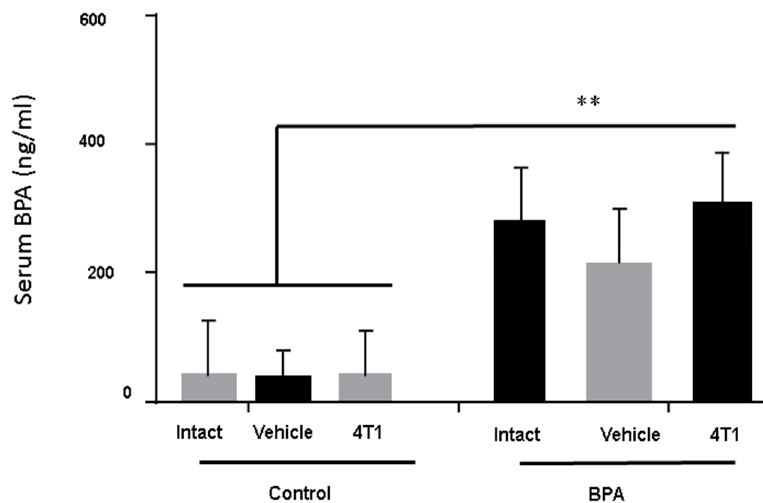
Figure 1. Bisphenol A (BPA) serum levels in male BALB/c mice. The BPA serum levels were measured in euthanised animals in control groups (without BPA treatment) n = 9, Vehicle (Ethanol) n = 7 and in the offspring of BPA-exposed females (BPA dose of 250 ng/kg/day) n = 7. Data are expressed as the mean and standard deviation of the tumour mass. ** p < 0.01.